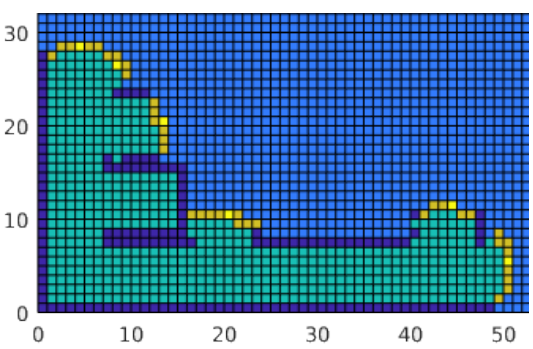
Figure 3. Frontier points. The different cell types are identified according to the following colour code: dark blue cells are Obs tacles, light blue cells are Unk nown, green cells are Free , orange cells are FP cells, and yellow cells are tasks